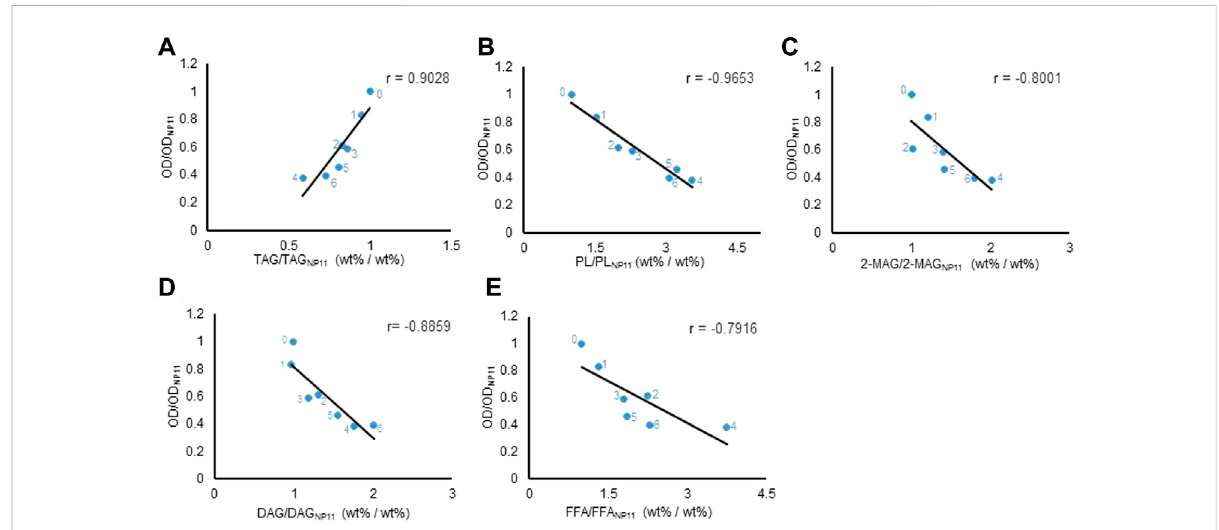
FIGURE 5 Different types of lipid content correlated with cell growth at the end of lipid production. Pearson correlation analysis between lipids content and OD 600 . Every lipid content and OD 600 were normalized before Pearson correlation analysis. The horizontal axis was the normalization result of differentlipids ’ averagecontentofsixengineeringstrainsrelativetoNP11,theverticalaxiswasthenormalizationresultofOD 600 averagevaluesofsix engineeringstrainsrelativetoNP11.ThervaluewasthePearsoncorrelationcoef fi cient.Thevalueswereplottedonalinearscalegraph. (A) TAG. (B) PL. (C) 2-MAG. (D) DAG. (E) FFA. The number labeled next to the point, 0, 1, 2, 3, 4, 5, and 6 represented strains NP11, LROi815, DLi2, DLAi12, TGL544, DLiT223, and DLAiT1226, respectively. TAG, triacylglycerols;DAG, diacylglycerols; FFA, freefatty acids;2-MAG,2-monoglyceride;PL, polar